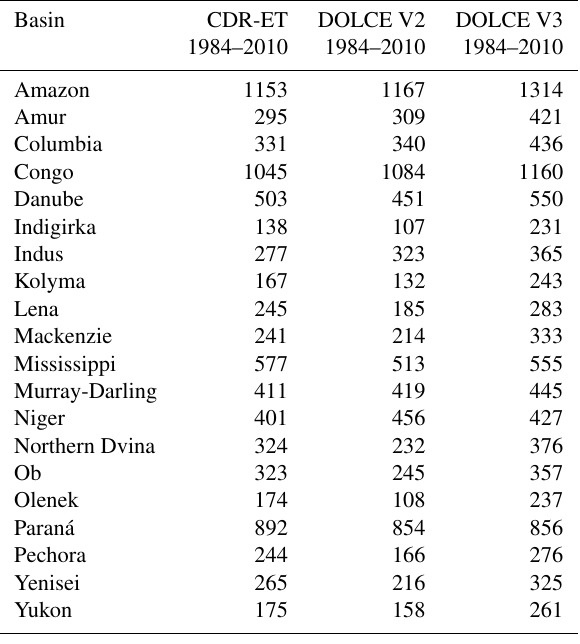
Table 2. Mean annual ET aggregates in millimetres per year (mmyr − 1 ) across 20 river basins calculated for DOLCE V2, DOLCE V3 and CDR-ET (Table 4 of Zhang et al., 2018) over a common period 1984–2010. CDR-ET is derived by merging 10 available ET datasets into a hybrid ET which then receives correc- tions, so the surface water budget established by derived hybrid es- timates of the other hydrological variables is closed.